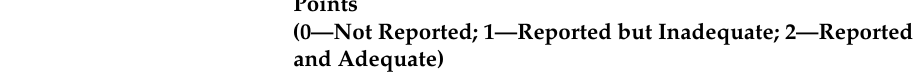
Table 3. The results of methodological quality assessment of pilot CTs based on the